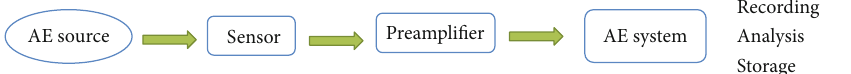
Figure 1: Principles of AE detection. Acoustic emission signal is collected by the sensor, and the preampli fi er transmits it to the acoustic emission